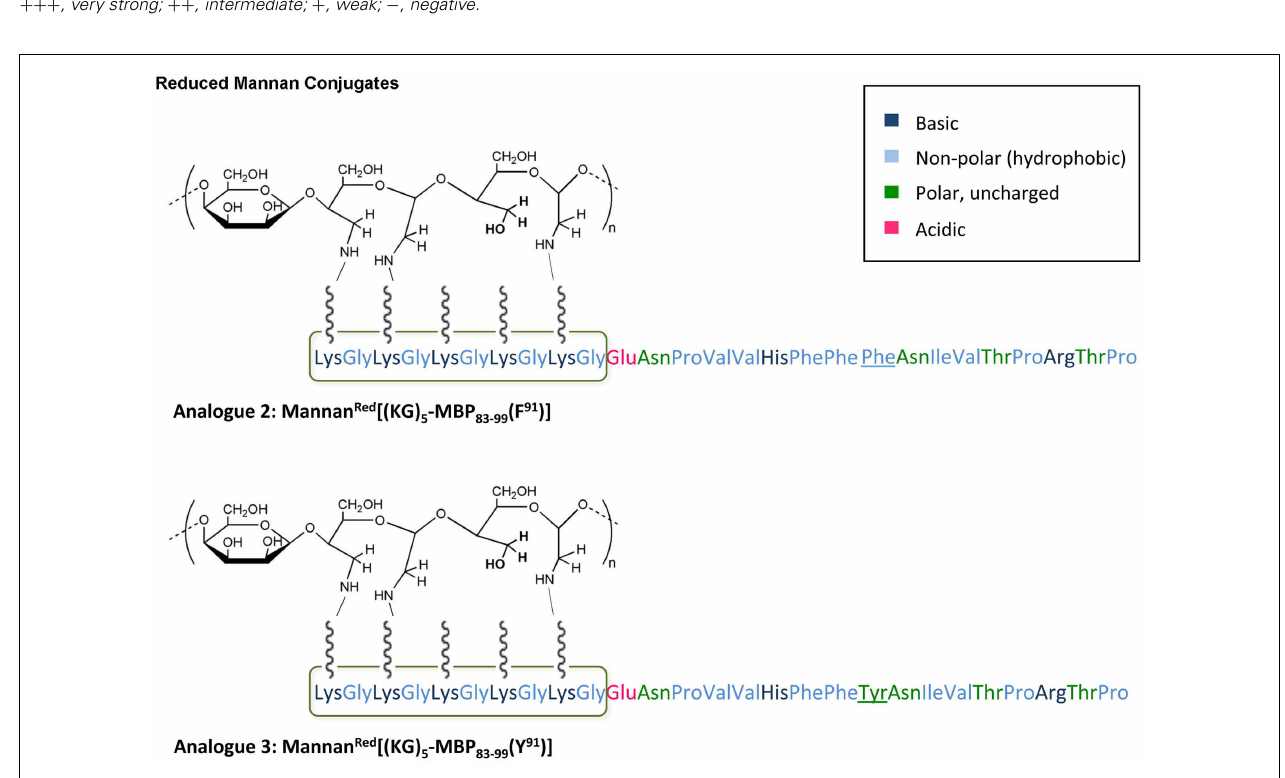
FIGURE 1 | Schematic presentation of analog 2: Mannan Red [(KG) 5 -MBP 83–99 (F 91 )] and analog 3: Mannan Red [(KG) 5 -MBP 83–99 (Y 91 )] .The polarity of each amino acid is colory presented.